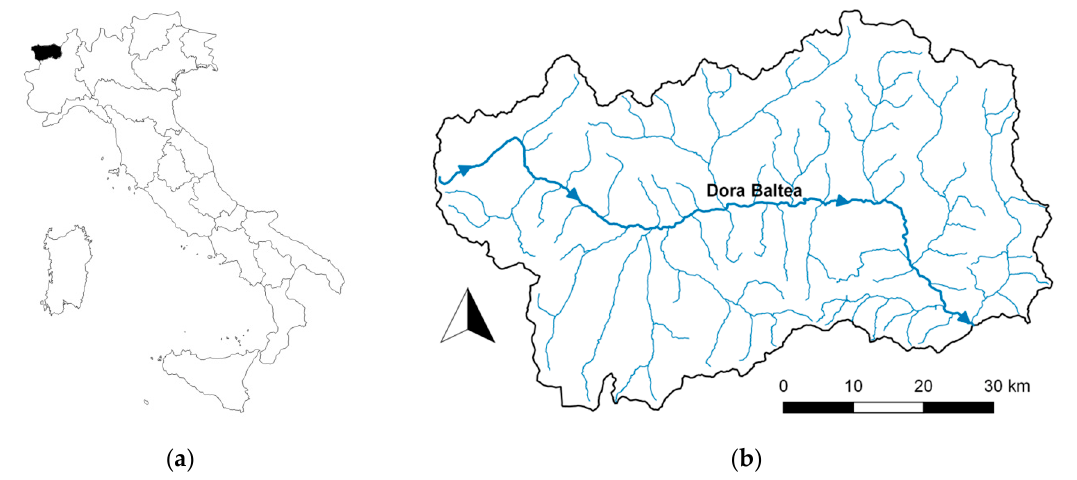
Figure 1. ( a ) Location of Aosta Valley in Northwest Italy, within the Alps. ( b ) Main regional hydrography network: Dora Baltea, tributary of the Po river (highlighted with a thicker line), and its main tributaries. The arrows indicate the flow direction for Dora Baltea River.